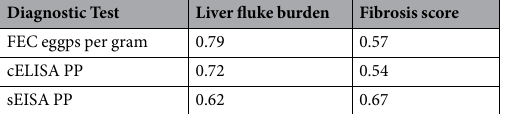
Table 3. Spearman rank correlation coefficients between the number of parasites in the liver, fibrosis score and continuous test results of each diagnostic test. The spearman rank correlation is a nonparametric test of whether there is a statistical relationship between two variables. A correlation coefficient of 1 indicates a perfect positive correlation, while a correlation coefficient of − 1 indicates a perfect negative correlation and a correlation coefficient of 0 indicates no correlation. In this case p < 0.001 for all coefficients indicate that these correlations were statistically significant.